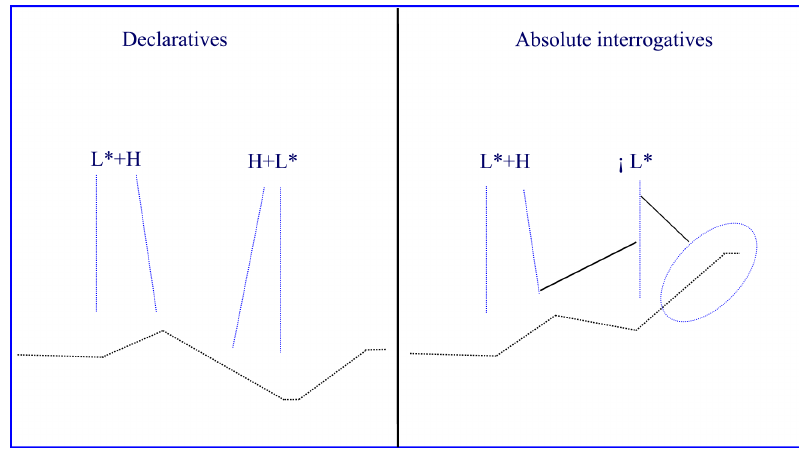
Figure 7. Schematic of DS declaratives and nuclear upstepped analysis of absolute